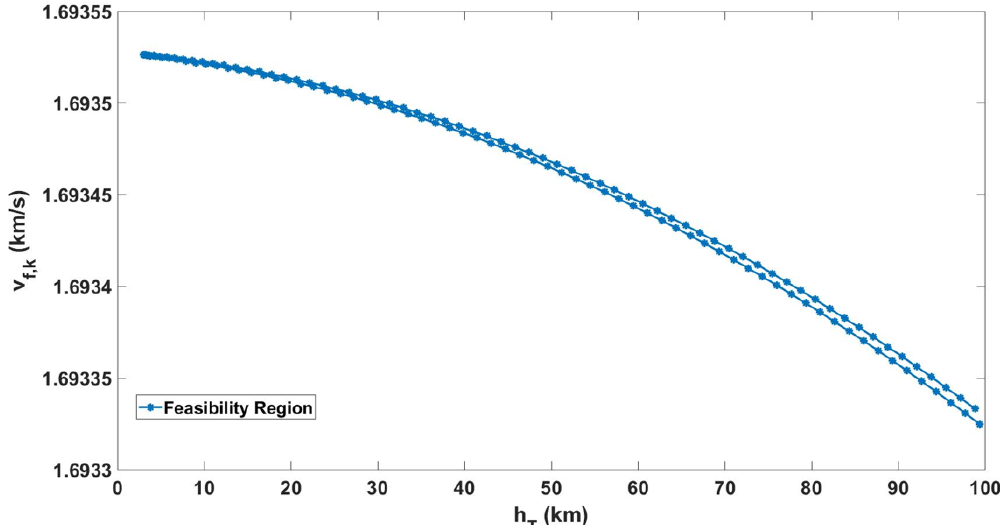
Figure 23. Relative velocities of the spacecraft with respect to Phobos during the hyperbolic